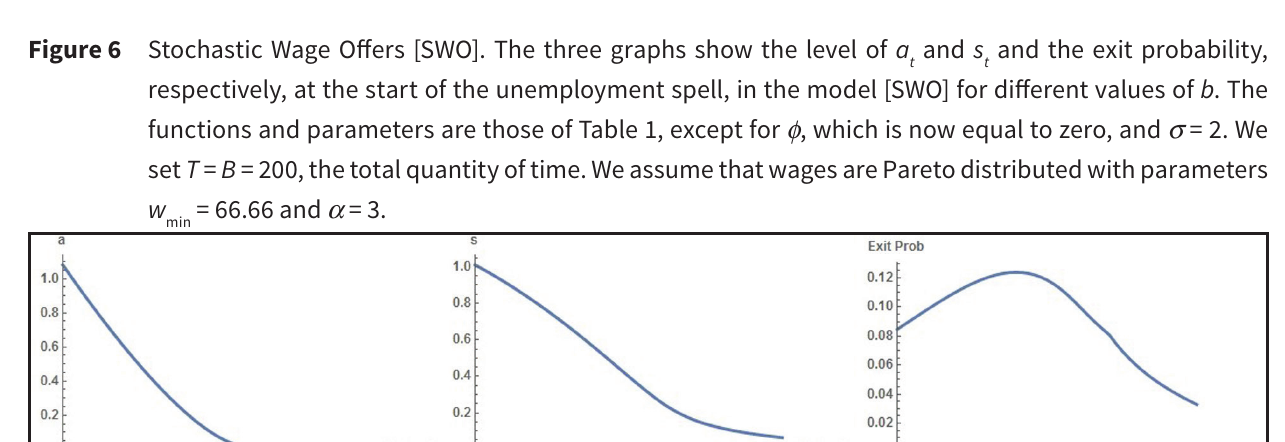
and s and the exit probability, t t